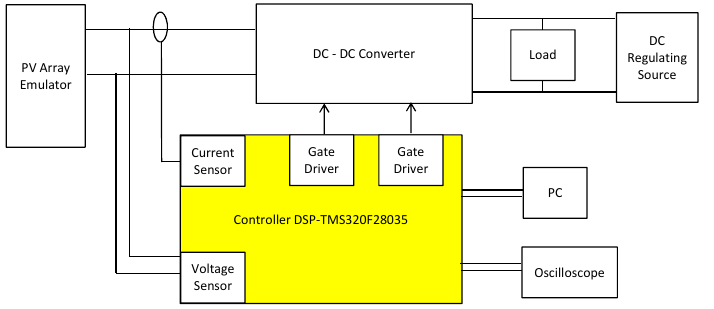
Figure 9. Block diagram of the experimental setup.